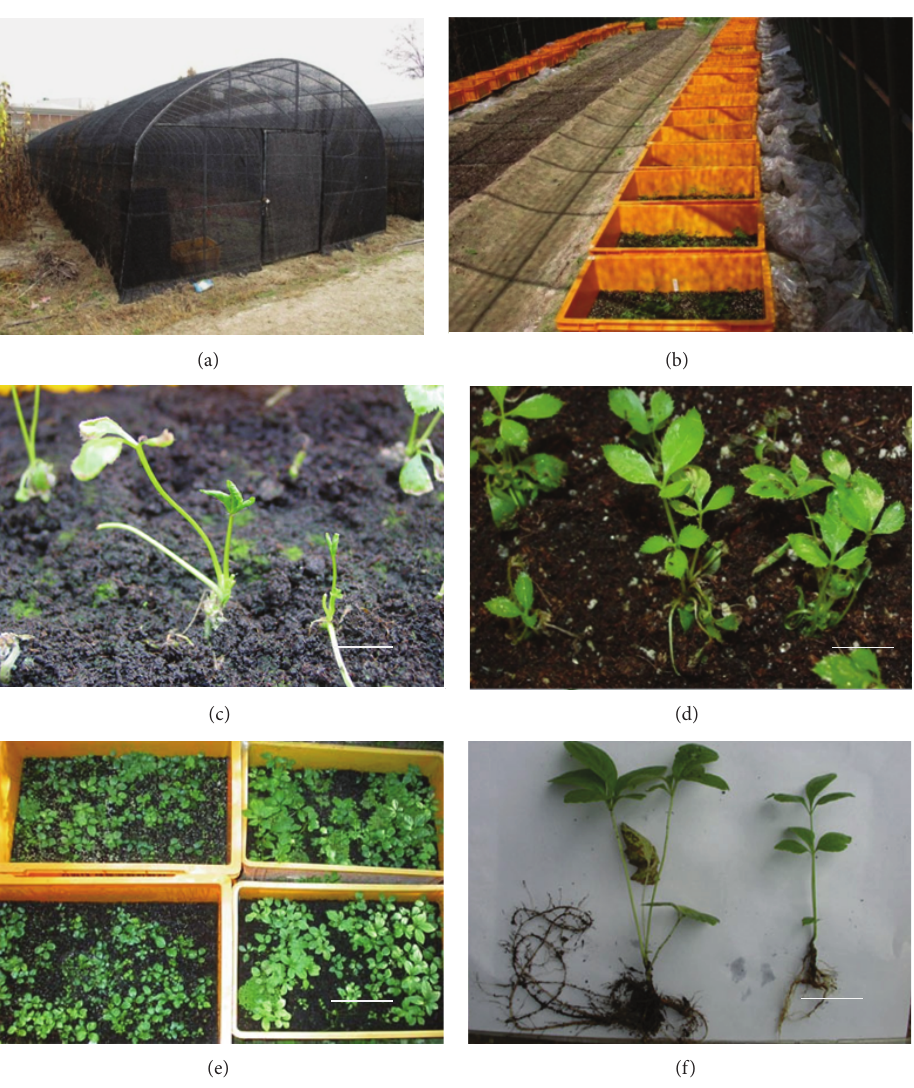
Figure 3: Transplantation of bioreactor cultured SE-derived plantlets of Siberian ginseng in simple sunshade shed. (a) Simple shed covered with a 50% sunshade net. Bar = 1.1m. (b) In vitro plantlets were transferred to plastic boxes (35 × 55 × 15) containing a mixture of sand and soil. Bar = 20 cm. (c) HS2 plantlets 2 weeks after transplantation. Bar = 1cm. (d) TS2 plantlets after transplantation for 2 weeks. Bar = 1cm. (e) HS2 (left) and TS2 (right) plantlets after transplantation for 6 months. Bar = 16cm. (f) TS2 (left) and HS2 (right) plantlets after transplantation for 6 months. Bar = 6cm.